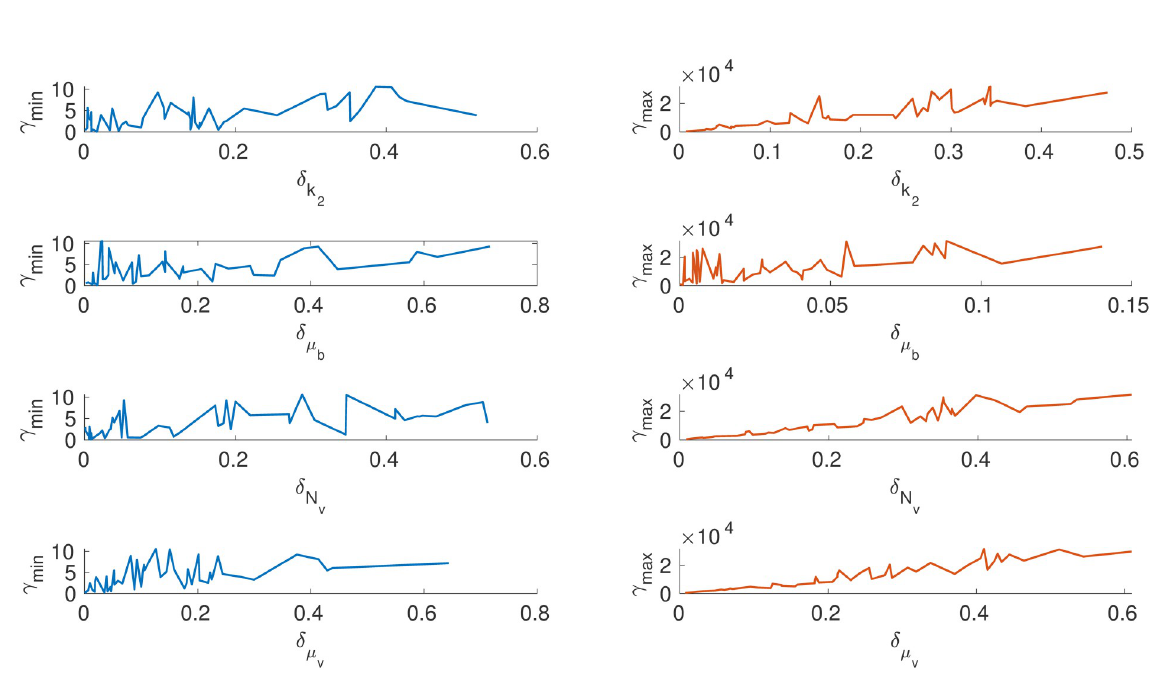
Fig 13. x -axis depicts the relative distance of the particular parameter θ from its reference value y � . y -axis on the left is the minimum sum- i i square deviation, and on the right maximum sum-square deviation from y � ( t ). Parameter μ b is sensitive compared to other parameters, and the linearly increases in the direction of maximum deviation. Summery of results is given in Table sensitivity of the parameter N v